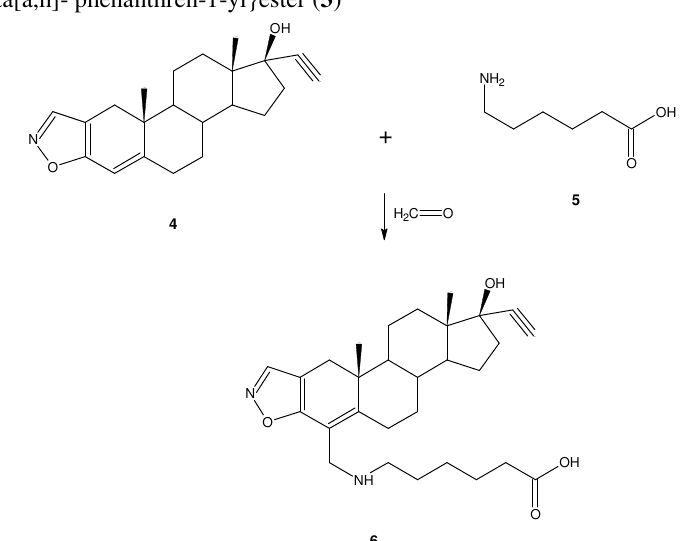
Figure 2. Synthesis of 6-[(1-ethynyl-1-hydroxy-10a,12a-dimethyl-2,3,3a,3b,4,5,10, 10a,11,12,12a, dodeca-hy-dro-1 H -7-oxa-8-aza-dicyclopenta[a,h]phenanthren-6-yl-methyl)- amino]hexanoic acid ( 6